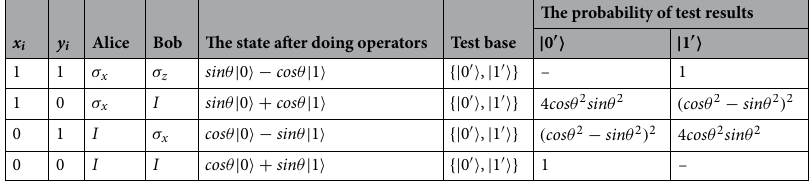
Table 1. The test